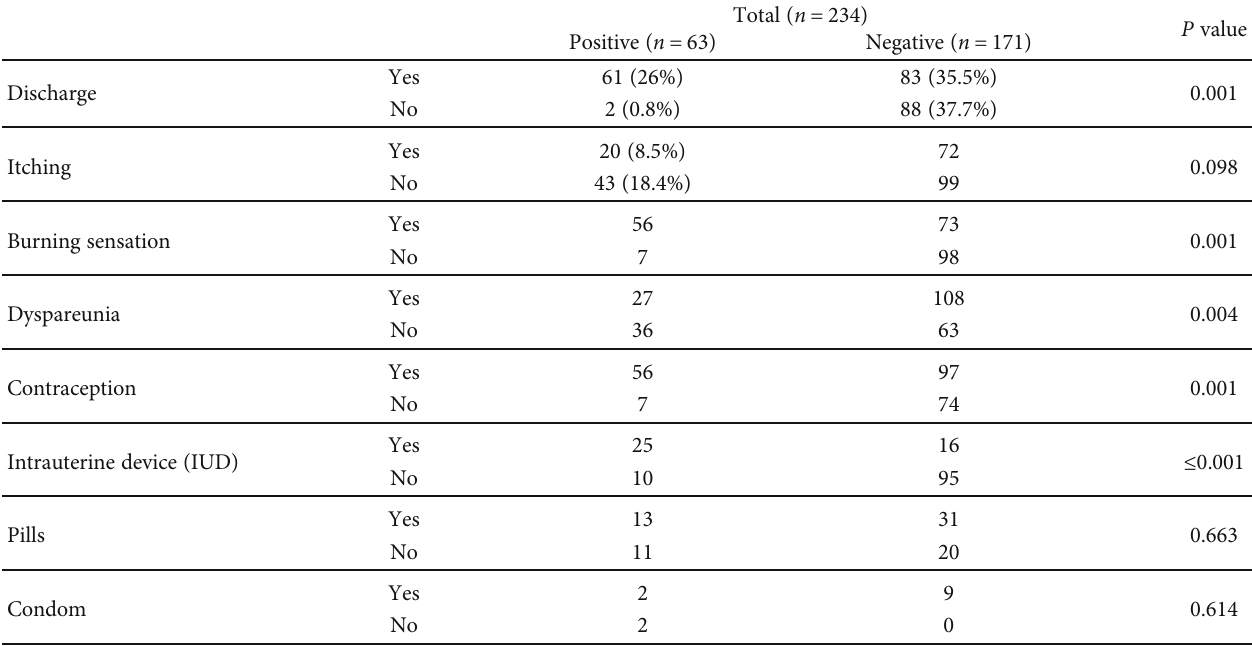
Table 5: Clinical complaints and contraception methods used in relation to nPCR